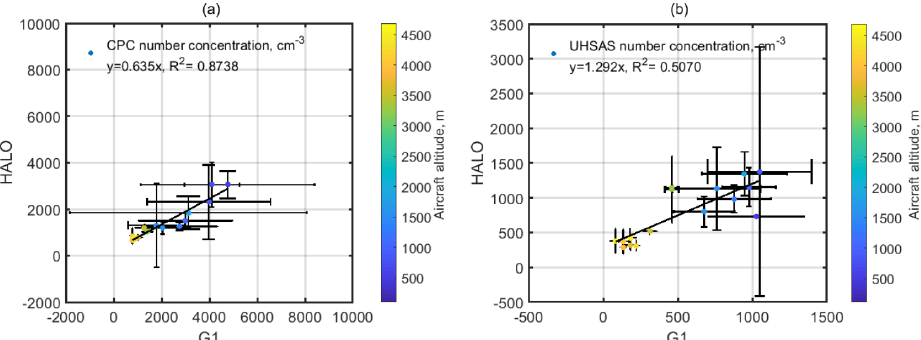
Figure 8. The G1 and HALO comparison for aerosol number concentration profiling measured by (a) CPC and (b) UHSAS (100–700nm) on 21 September.